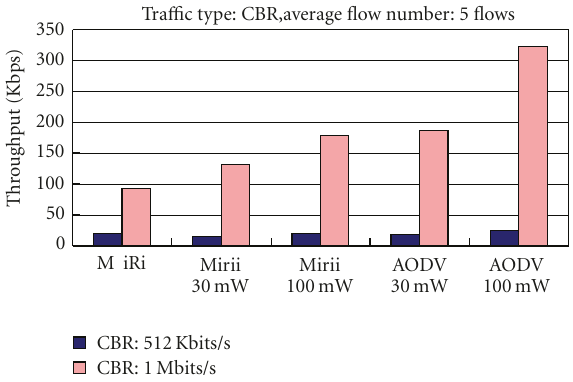
Figure 6: Average end-to-end delay of di ff erent tra ffi c load in a uniform network topology.